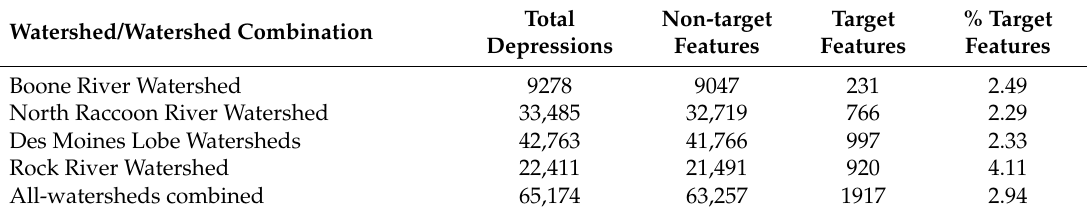
Table 2. The initial number of depressions identified within 500m buffer of perennial streams by watersheds. The depressions that had <100m 2 area outside an agricultural field and depressions that intersect the stream were excluded from analyses.